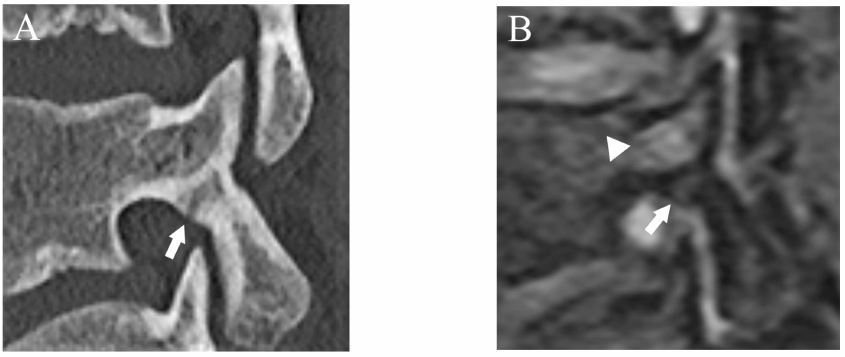
Figure 7. The case that lower fracture grade was assigned by DESS than CT. ( A ) CT suggests an incomplete fracture which was consistent with grade 2 (arrow). ( B ) DESS shows a subtle high signal in the cortex of the pars interarticularis and evaluated as grade 1 (arrow). BME is also detected